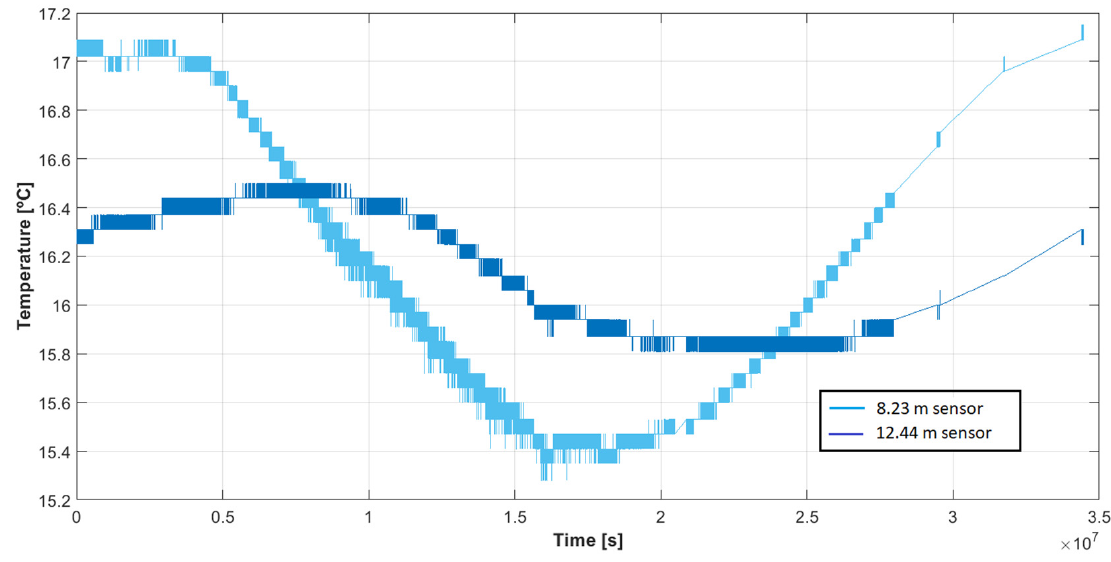
Figure 33. Temporal evolution of temperature at depths 8.23 and 12.44 m for the sensor DS18B20 over 405 days.